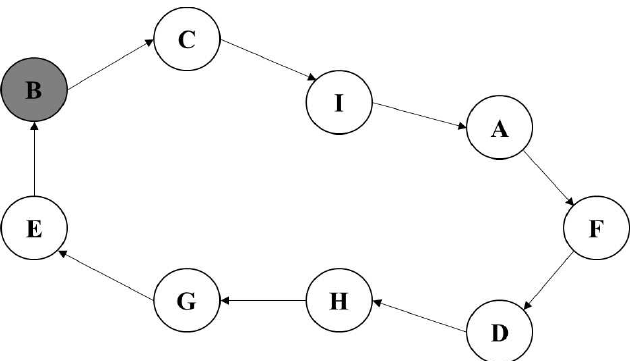
Figure 3. Expression of the above